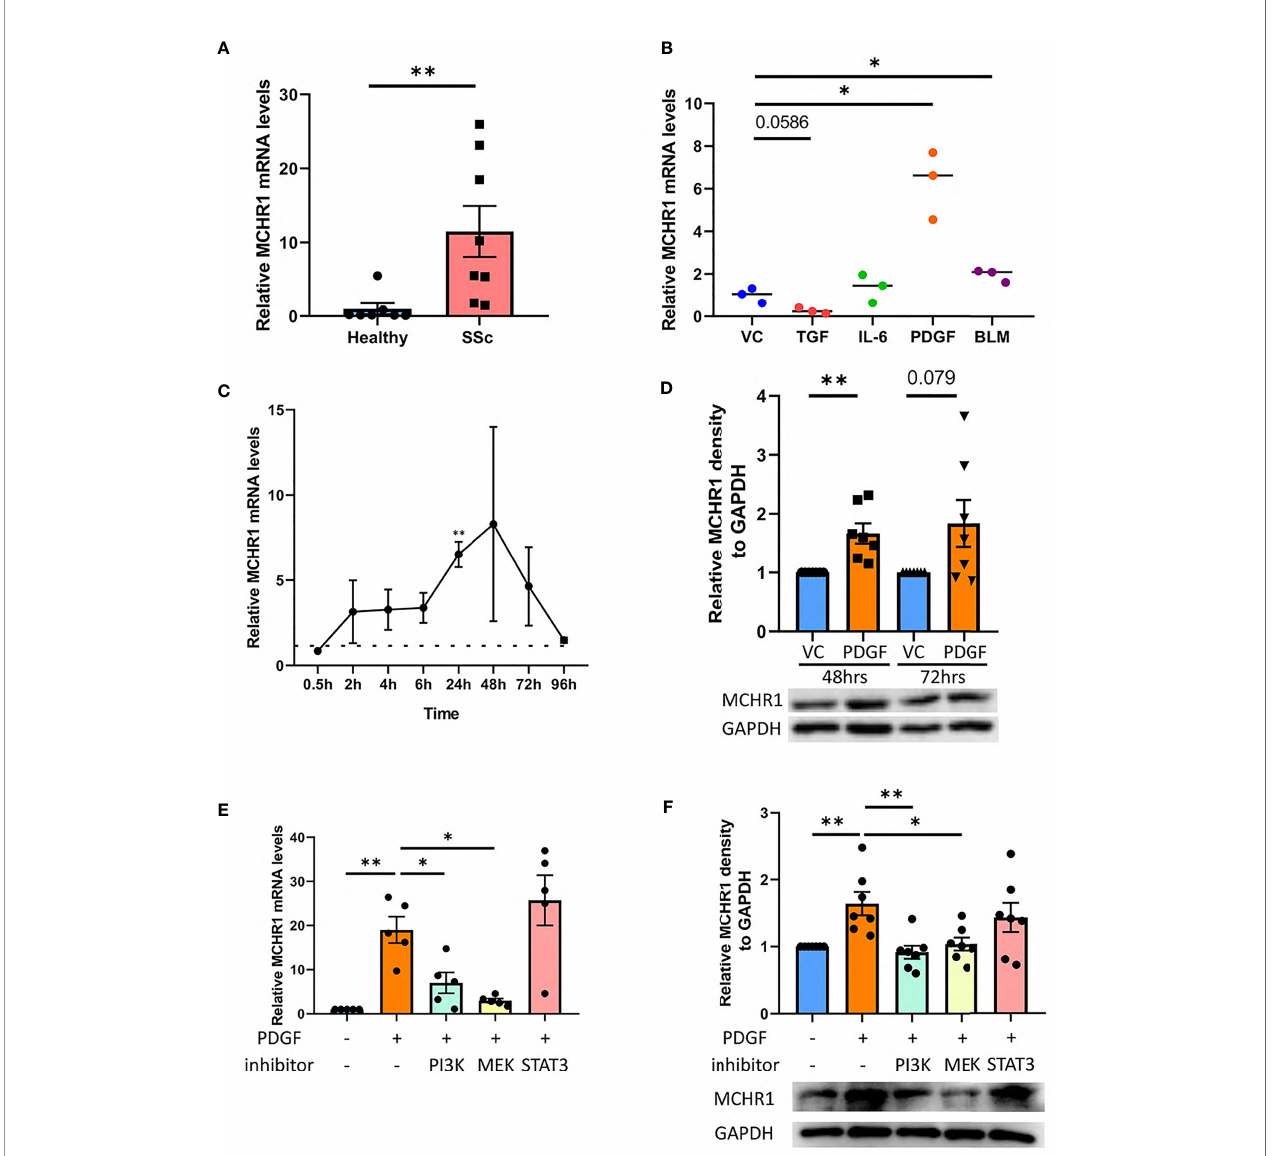
FIGURE 1 | MCHR1 expression in dermal fi broblasts. (A) MCHR1 expression in dermal fi broblasts of SSc patients (SSc) and healthy subjects (Healthy) was measured using qPCR (n = 8). (B) MCHR1 expression in NHDF treated with TGF b 1 (5ng/ml), interleukin 6 (IL-6, 20 ng/mL), PDGF-BB (PDGF, 40 ng/mL), bleomycin (BLM, 10 mU/mL), or vehicle control (VC) for 24 hrs (n=3). (C) MCHR1 expression levels in NHDF treated with PDGF-BB (40ng/ml) compared to vehicle control at the indicated time points (n=3). (D) Quanti fi cation of MCHR1 protein abundance relative to glyceraldehyde 3-phosphate dehydrogenase (GAPDH) in PDGF-BB- treated NHDF (40 ng/mL) for 48 and 72 hrs (n=7). Representative immunoblots are shown. (E) MCHR1 expression levels in NHDF incubated with 10 m M of the following inhibitors: LY294002 (PI3K), U0126 (MEK), 5 m M of StatticV (STAT3), DMSO as a vehicle control (n=5). PDGF-BB (40 ng/mL) was added 1 hour after inhibitors. NHDF were treated with PDGF-BB for 24 hrs. (F) Quanti fi cation of MCHR1 protein abundance relative to GAPDH in PDGF-BB-treated NHDF (40 ng/mL) for 48hrs in combination with inhibitors PI3K, MEK, STAT3 and DMSO as vehicle control (n=7). Representative immunoblots are shown below. *P < 0.05, **P < 0.01, error bars =